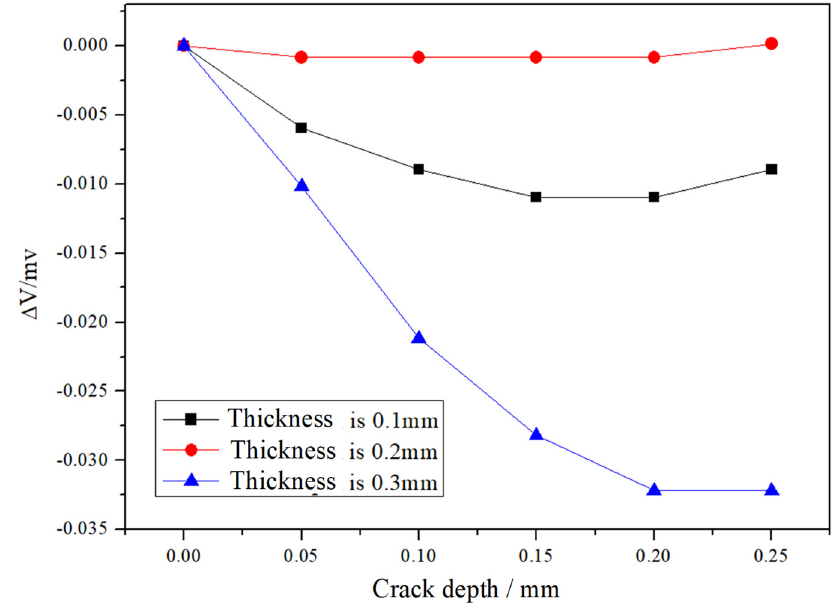
Figure 7. The variation of induced voltage of Coil 1 under different crack thicknesses.